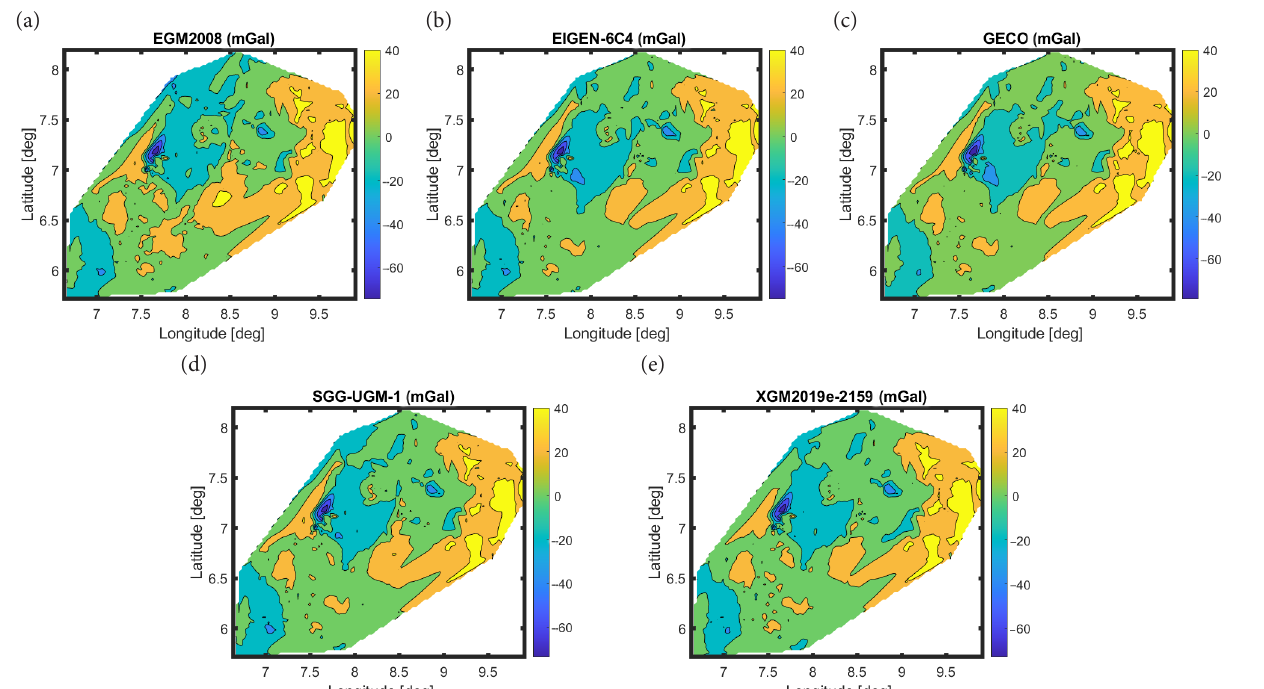
Figure 7. Differences between ground-based and GGM-derived free-air gravity anomalies computed